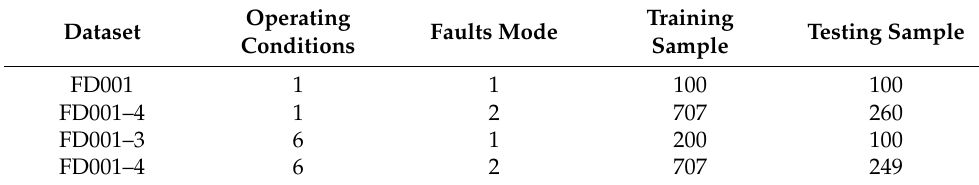
Table 5. The reconstructed dataset of